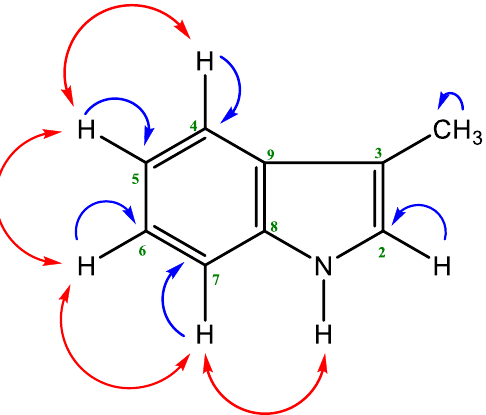
Figure 2. Key HSQC (blue) and COSY (red) correlations for compound 2 .